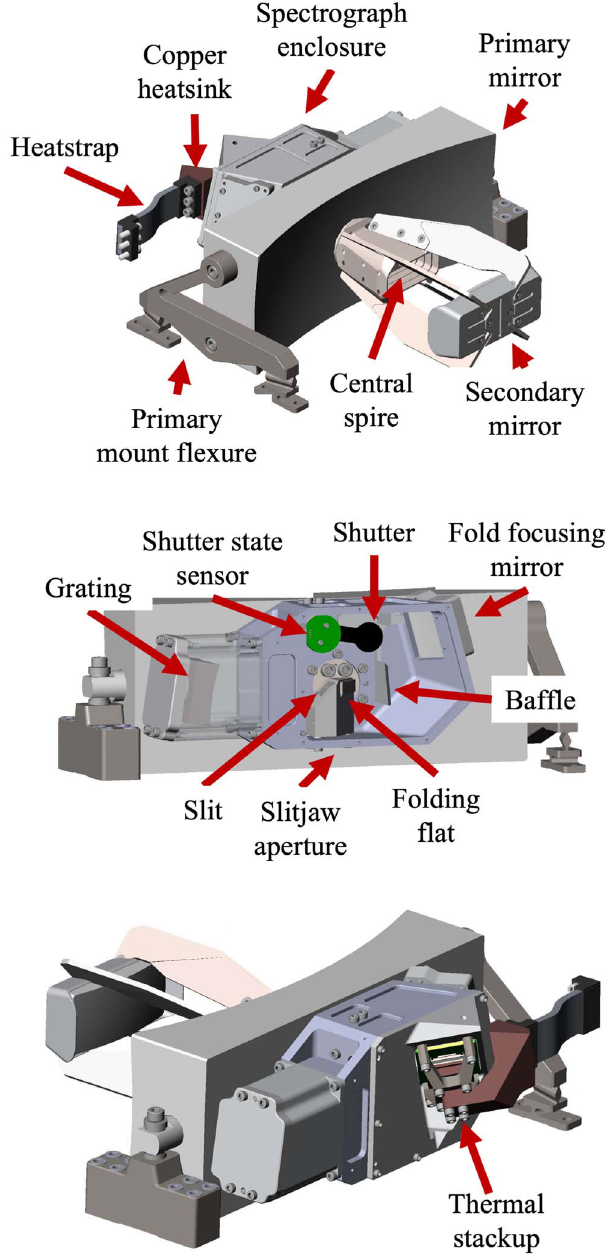
Figure 2. CAD renderings of the CUTE telescope and spectrograph. Top: front view of the Cassegrain telescope. Middle: view of the spectrograph internals. Bottom: view of the fully closed-out spectrograph, including the detector and the thermal strap attached to the spacecraft